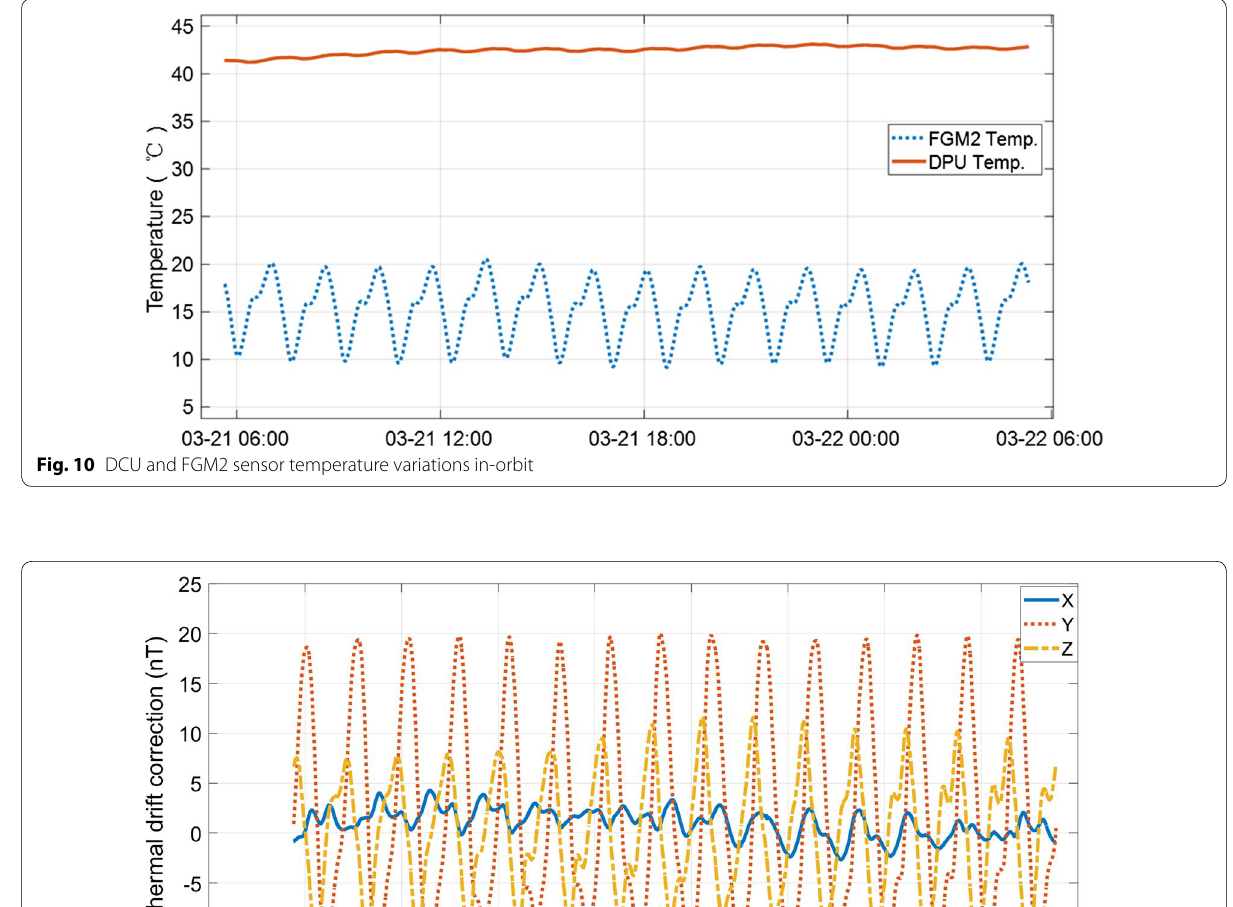
results for data from March 7th, 2018 to November 15th, 2018. The FGM linear parameters are stable; how- ever, these parameters will be updated routinely every day.